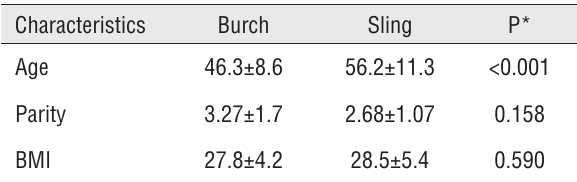
Table 1 - Demographic